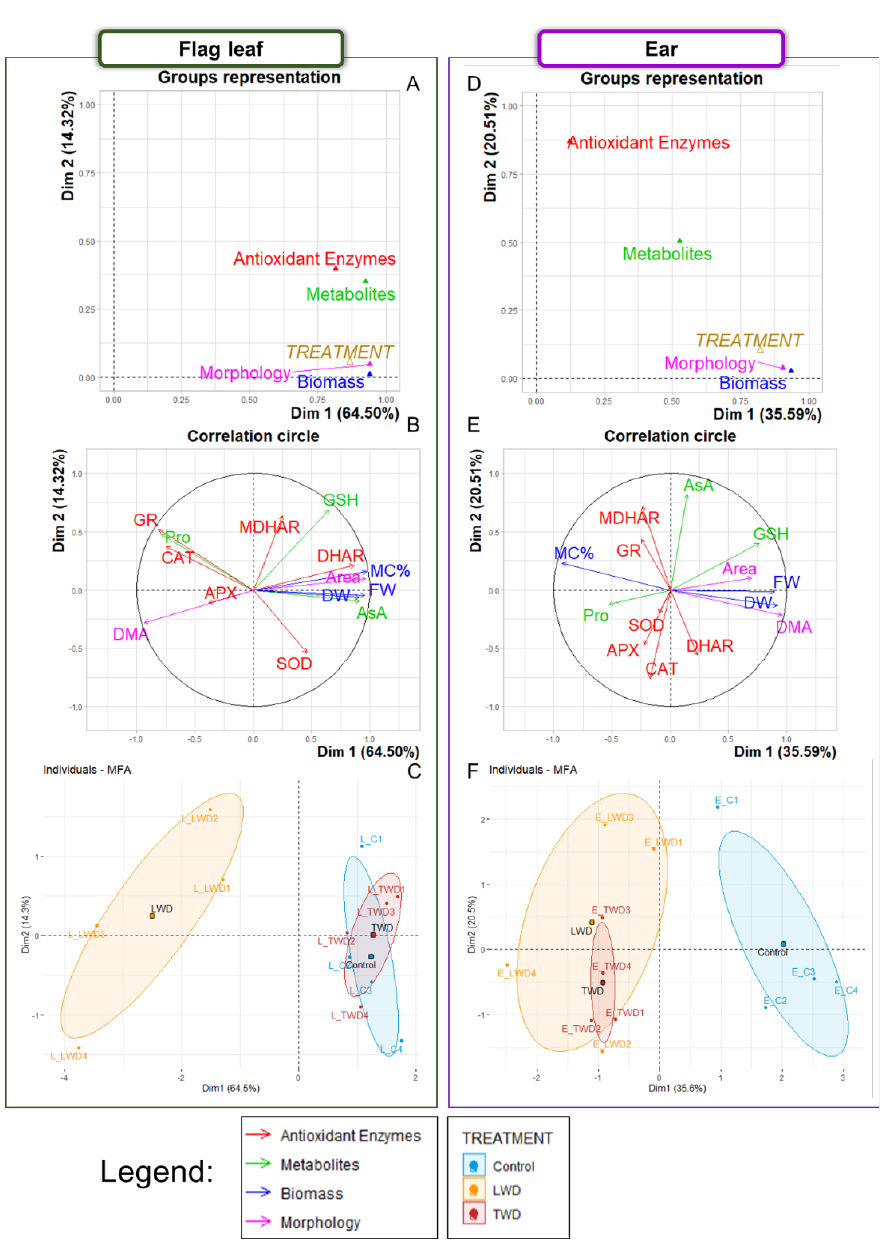
Figure 1. Multiple factorial analysis for flag leaves (Panels A – C ) and ears (Panels D – F ) of potted wheat subjected to two different water regimes under elevated CO 2 and high temperature. Dim, Dimension; DW, dry weight; FW, fresh weight; MC%, moisture content percentage; Pro, proline content; AsA, total content of ascorbate (AsA plus DHA); GSH, total content of glutathione (GSH plus GSSG); SOD, superoxide dismutase; CAT, catalase; APX, ascorbate peroxidase; DHAR, dehydroascorbate reductase; MDHAR, monodehydroascorbate reductase; GR, glutathione reductase. Two factors were defined: ORGAN , which included the flag leaf and ear categories, and TREATMENT , which included control, long water deficit (LWD) and terminal water deficit (TWD) categories. The green biomass and biochemical traits were divided into four groups: Antioxidant Enzymes (CAT, SOD, APX, DHAR, MDHAR and GR), Biomass (FW, DW and MC%), Metabolites (Pro, AsA and GSH), Morphology (Area and DMA). Panels A and D contain the group representation plots showing the correlation between the trait groups of the continuous variables and the two factors with the first and second dimensions of the MFA axes. Triangles represent the relative position of each group with the axes. Panel B and E contain the correlation circle plots showing the correlation of variables with the MFA axes. Panel C and F contain the individuals-MFA plots showing the position of the individuals in the MFA by organ and treatment. Dots indicate individuals. Ellipses around each treatment were